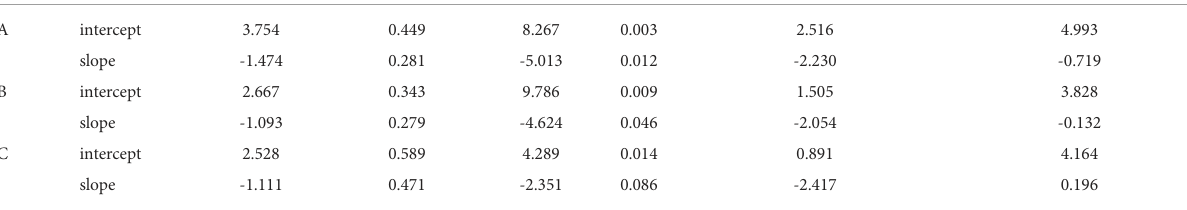
TABLE 3 Results of regression models of cross-reactive repertoires: the average values of slopes and intercepts for each donor are shown.